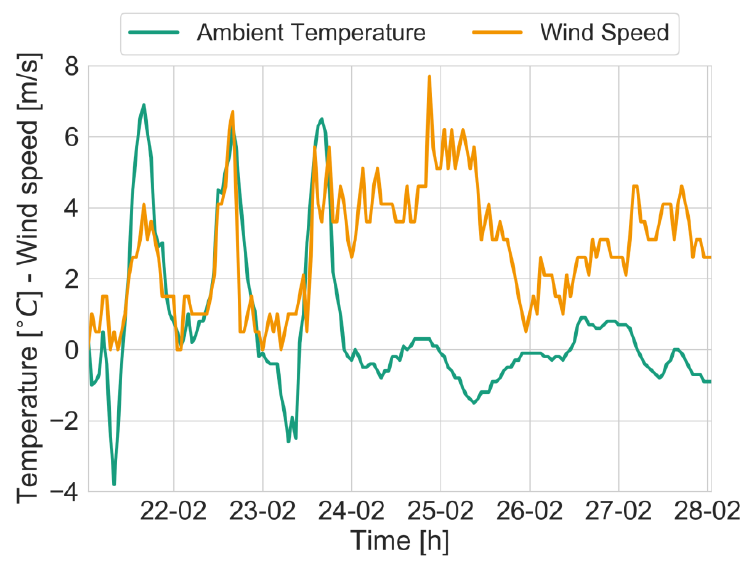
Figure 18. Weather conditions (ambient temperature and wind speed) during the simulation period.